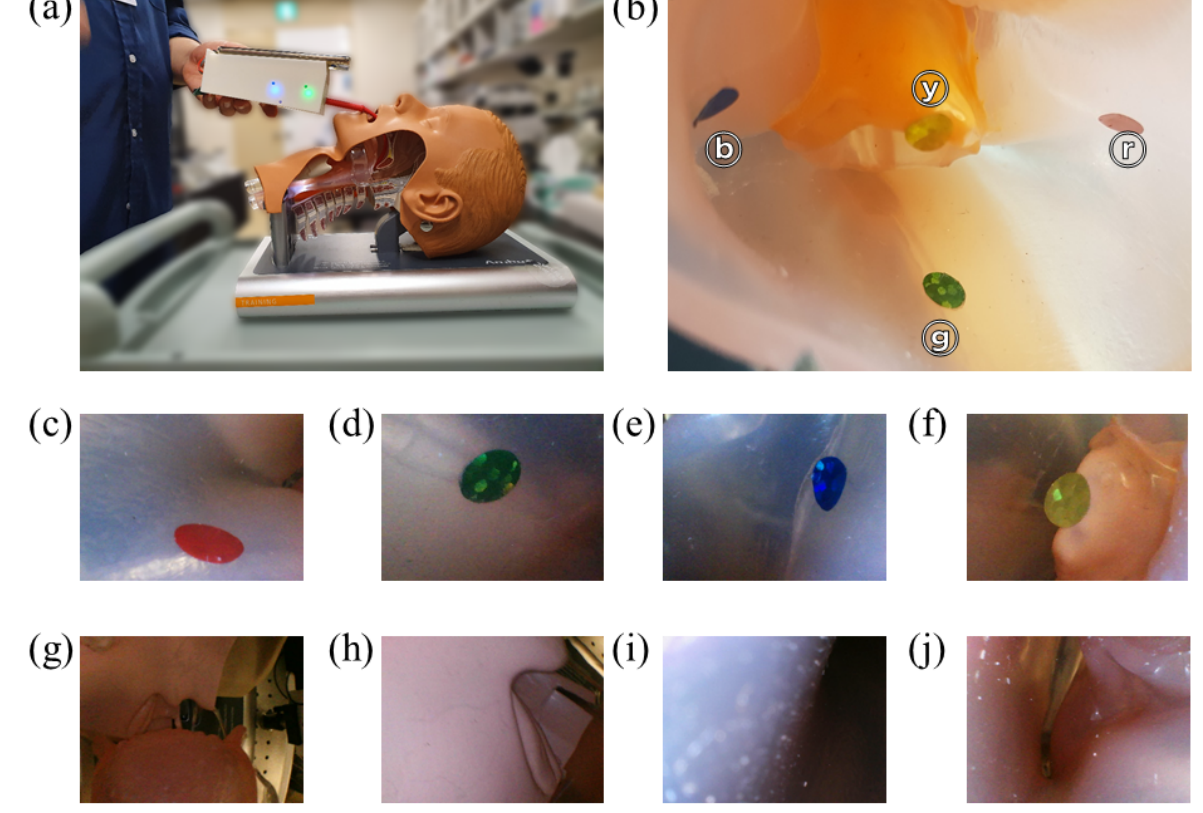
Figure 13. Articulation experiment on the laryngopharyngeal phantom: (a) endoscope experiment in operation, (b) placement of stickers attached as indices in the oropharynx area of the phantom (upper side, yellow ⓨ ; on the left, blue ⓑ ; on the right, red ⓡ ; and on the lower side, green ⓖ sticker), (c-f) images of the stickers obtained in the articulation mode, and (g-j) images captured by the camera, going deep from the oral cavity to the